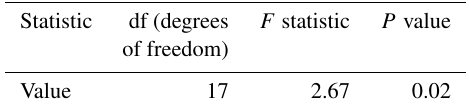
Table C1. Table displaying F -test results for the 2019 drought pe- riod risk assessment versus literature results.